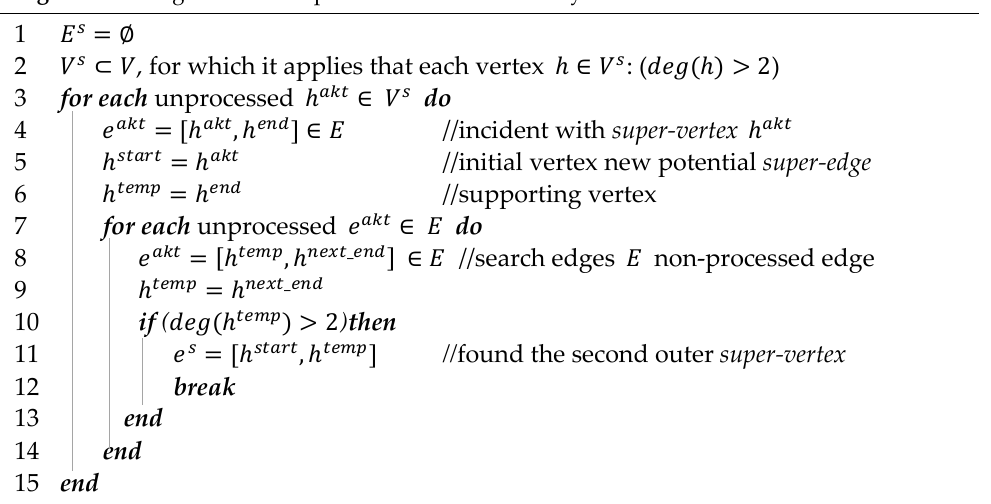
Algorithm 4: Algorithm concept of data-macro model layer. Algorithm 4. Algorithm concept of data-macro model layer.